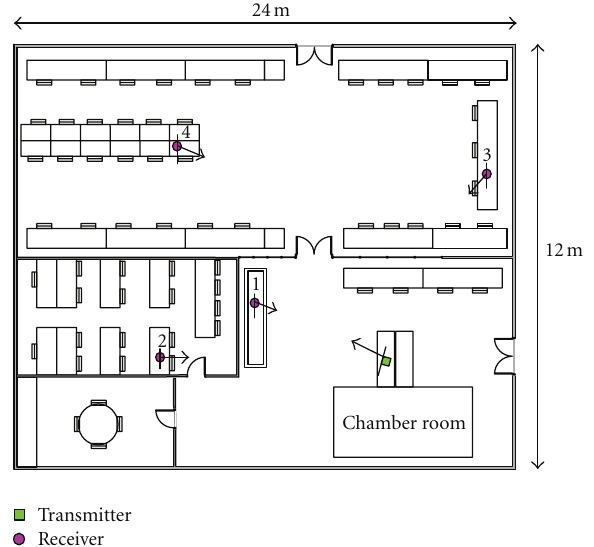
Figure 7: Measurement